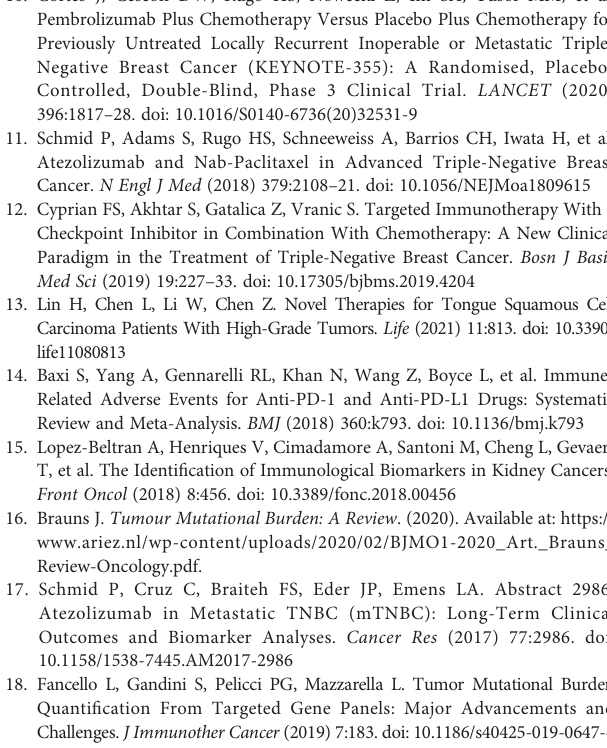
(B) The distribution of TMB value between two immune subtypes. TMB, tumor mutation burden; PFS, progression-free survival. Supplementary Figure 3 | Differential stromal/immune cell in fi ltration of the immune subtypes. (A-C) Box plots comparing the distribution of stromal/immune cellin fi ltrations in the two immunesubtypes. Each boxspans the interquartile range, with the lines representing the median for each group. Whiskers represent the absolute range. All outliers are included in the plot. Supplementary Figure 4 | Volcano plots of the Differentially expressed genes (DEGs)between two subtypes ineach dataset.Thecolorofthe data pointsdenotes thestatusofDEGs(redpoints:highlyexpressedinsubtype2samples;greenpoints: highly expressed in subtype1 samples). Supplementary Figure 5 | The importance of variables in the random forest model. Supplementary Figure 6 | Ten-year Kaplan – Meier curves for OS of 10 hub genes (from A – J : CD3D, CD3G CD247, IFNG, IL2RG, IRF1, IRF4, LCK, OAS2, and STAT1). TNBC patients were strati fi ed by the median value and the expression data came from the METABRIC dataset. p value was calculated by the log-rank test among high and low expression groups. METABRIC, Molecular Taxonomy of Breast Cancer International Consortium; OS, overall survival. Supplementary Figure 7 | Five-year Kaplan – Meier curves for OS of 6 hub genes (LCK, CD3G, CD247, IL2RB, IRF1, and IFNG). TNBC patients were strati fi ed by the median value and the expression data came from the IMvigor210 dataset. p value was calculated by the log-rank test among high and low expression groups. OS, overall survival. Supplementary Figure 8 | Five-year Kaplan – Meier curves for OS of 5 hub genes (CD3G, IL2RG, IRF4, OAS2, and STAT1). TNBC patients were strati fi ed by the median value and the expression data came from the IMvigor210 dataset. p value was calculated by the log-rank test among high and low expression groups. OS, Overall Survival; TNBC, triple-negative breast